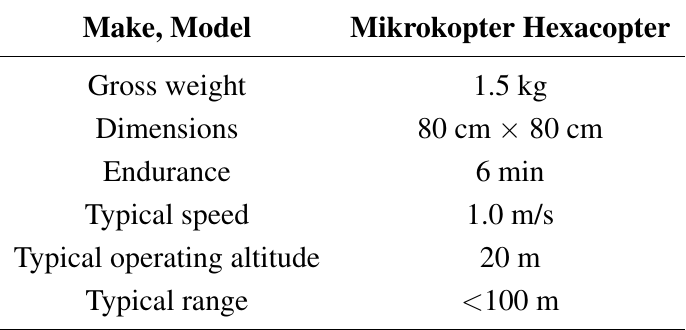
Table 1. UAV technical